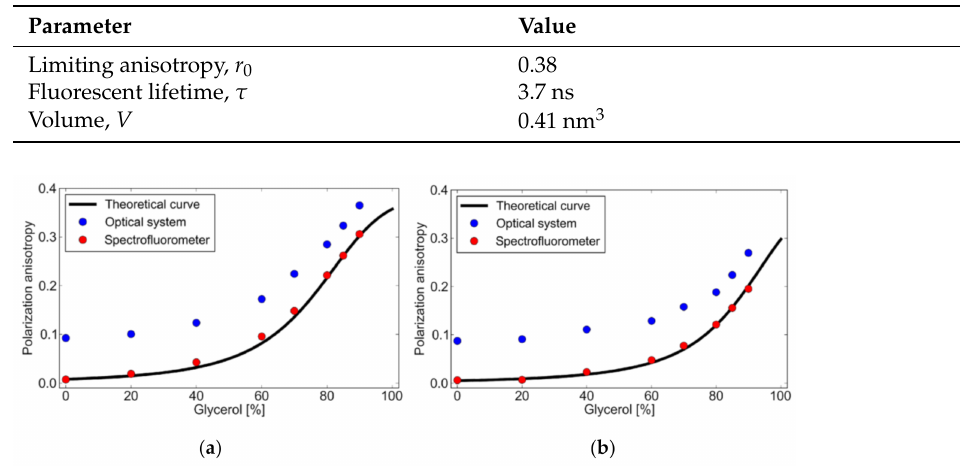
Table 1. Physical properties of fluorescein.